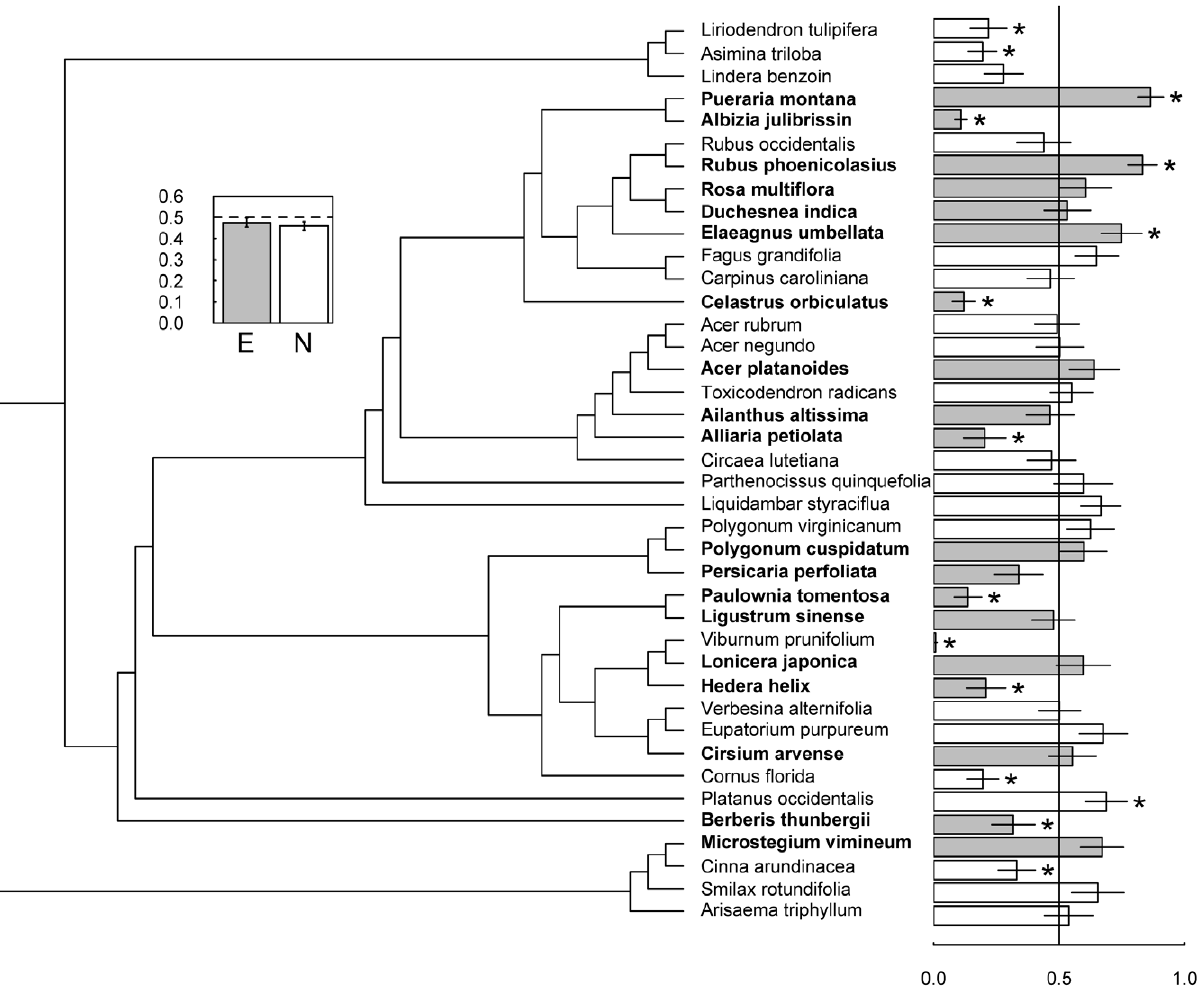
Figure 1. Plant origin does not predict native caterpillar preference for extracted chemistry. Preference of caterpillars for secondary chemistry extracted from 21 native (open bars) and 19 exotic (filled bars) plant species. Bars represent mean ( 6 1 SE) fraction of extract eaten relative to total amount of diet eaten. Phylogenetic relationships are shown without branch lengths for clarity, although branch lengths were used in statistical analysis of phylogenetic influence (see text). Asterisks beside bars denote significantly (P , 0.05, paired t-tests) deterrent or stimulatory extracts from individual plant species. Inset: overall mean ( 6 1 SE) fraction eaten by species origin (ANCOVA with caterpillar mass as covariate; origin effect P=0.76).